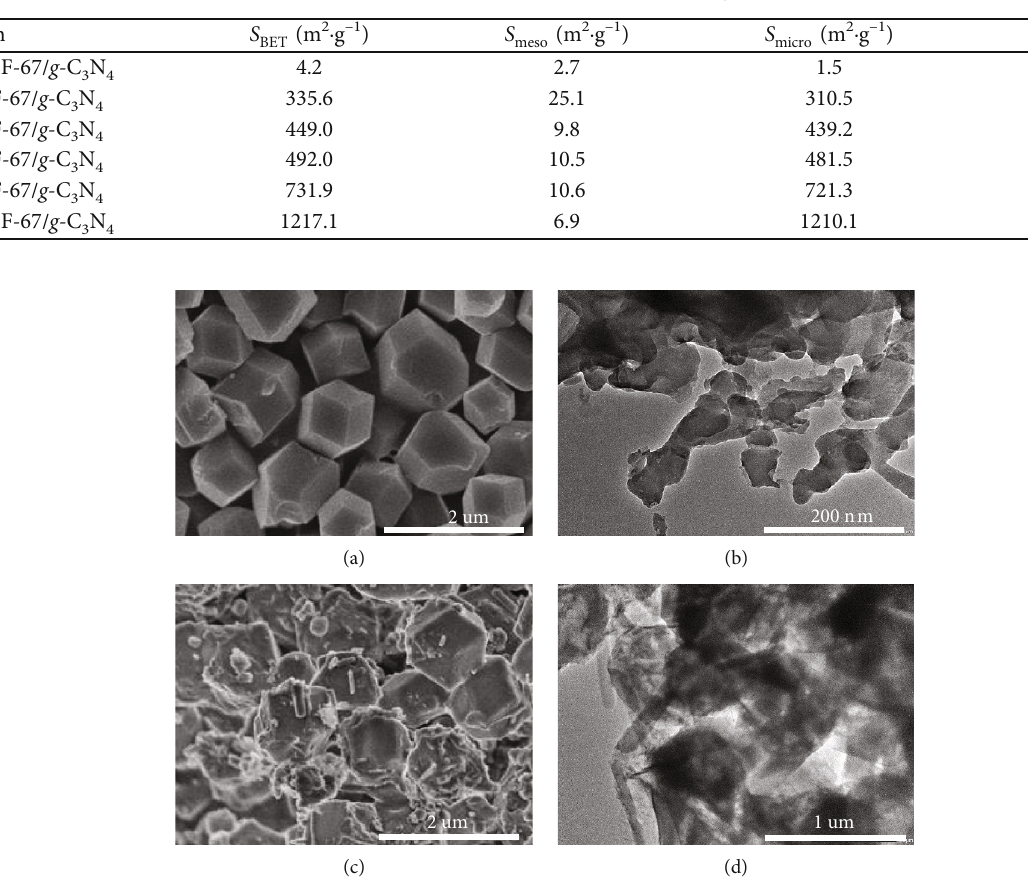
Table 1: Textural properties of ZIF-67/ g -C